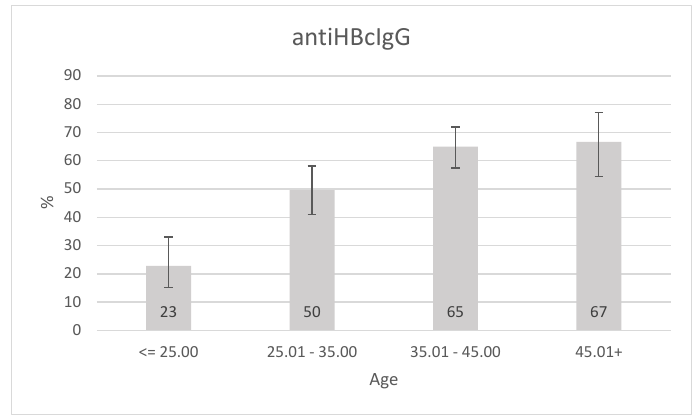
Figure 1. Anti HBc IgG positivity prevalence according to age, error bars represent 95% CI. p for trend < 0.0001.